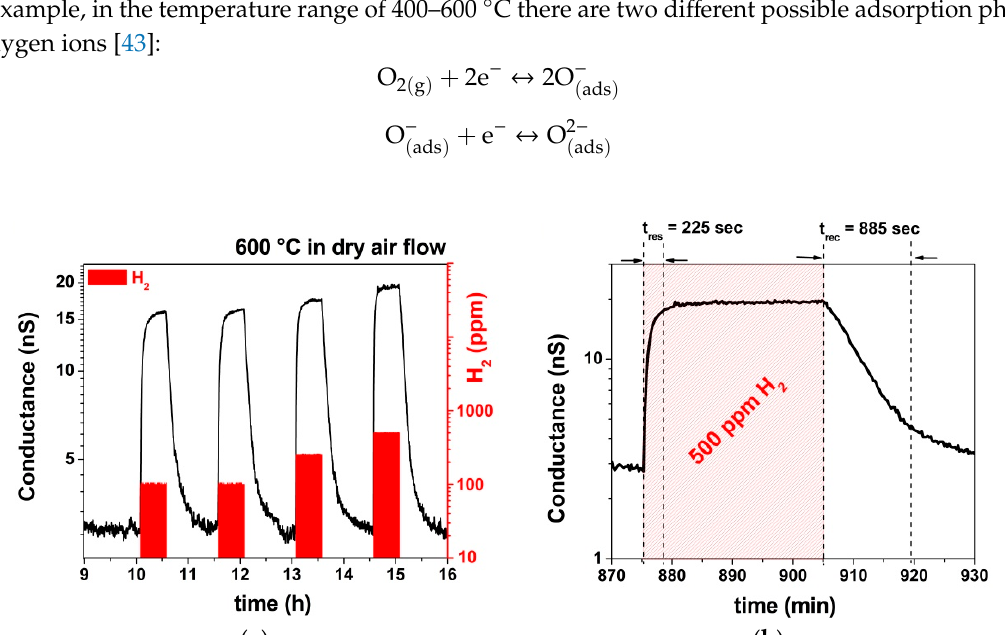
Figure 5. ( a ) Isothermal dynamic responses of nanoporous TiO 2 towards 100 ppm, 250 ppm, and 500 ppm H 2 gas at 600 °C. ( b ) Response and recovery curves towards 500 ppm H 2